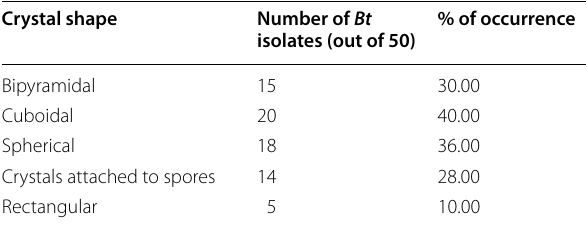
Table 2 Crystal shapes of Bt isolates